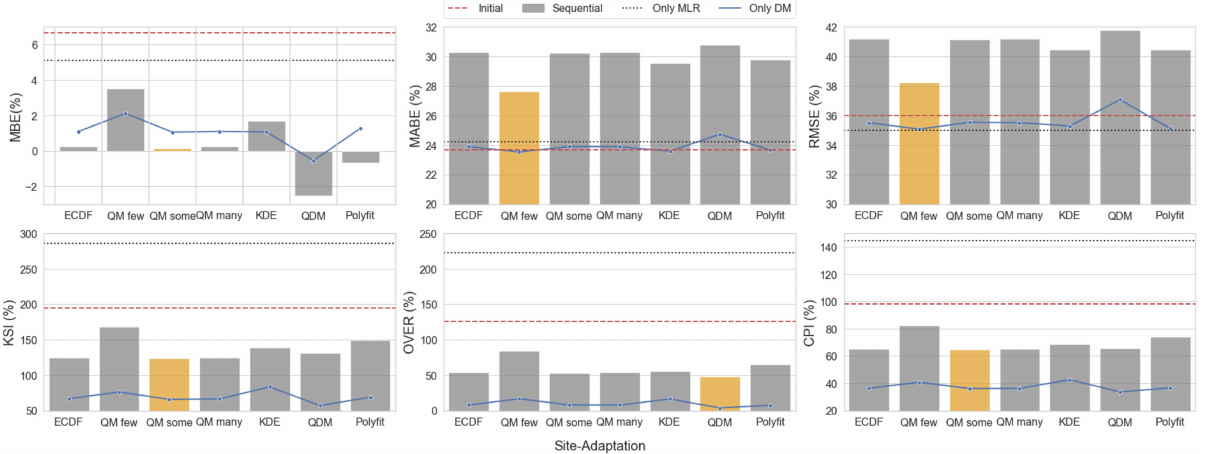
Figure 7. Same as Figure 5 but for DNI in the clear-sky